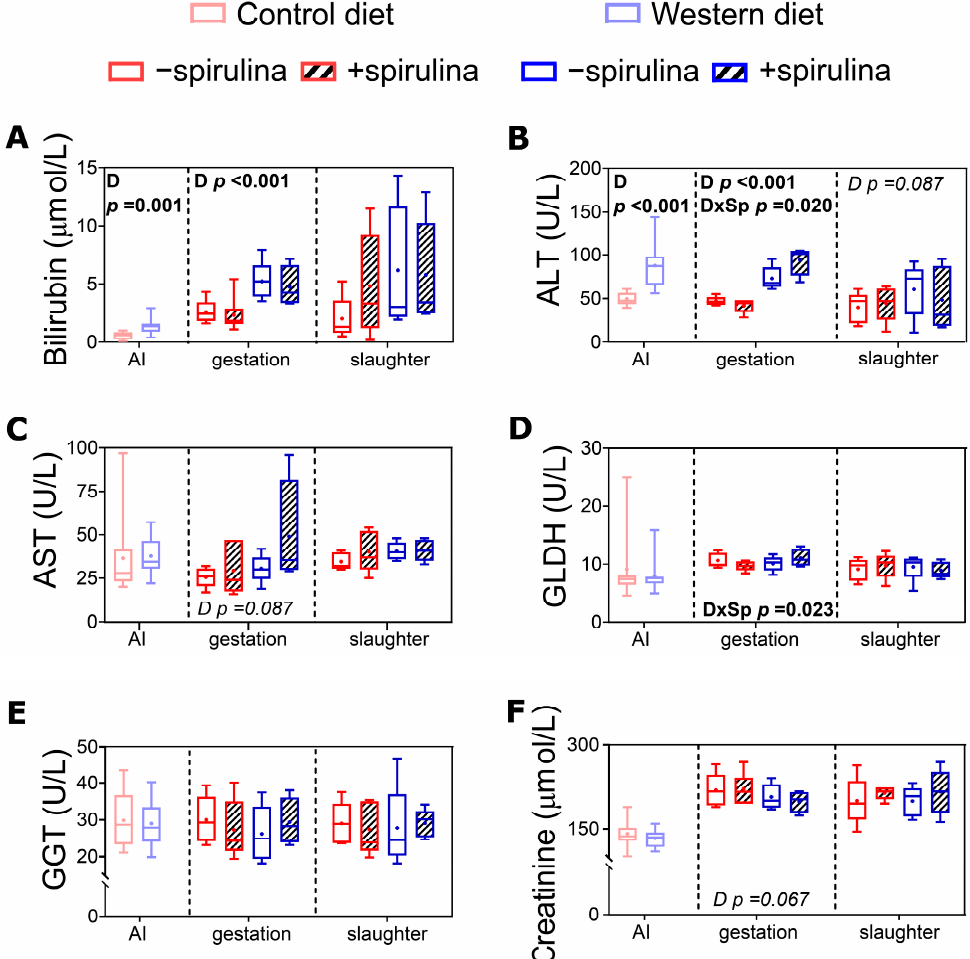
Figure 7. Biomarkers of organ functionality in serum of sows at artificial insemination (AI), 30 days before calculated farrowing (gestation), and 5 weeks post-lactation (slaughter). ( A ) Concentration of serum bilirubin, activities of ( B ) serum alanine transaminase (ALT), ( C ) serum aspartate transaminase (AST), ( D ) serum glutamate dehydrogenase (GLDH) 1 , ( E ) serum gamma-glutamyl transferase (GGT), and ( F ) concentration of serum creatinine. CTR: control diet; WES: Western diet; D: diet; Sp: spirulina. Data are presented in boxplots with Spear style whiskers (min to max). Pairwise comparison showed no significant difference.